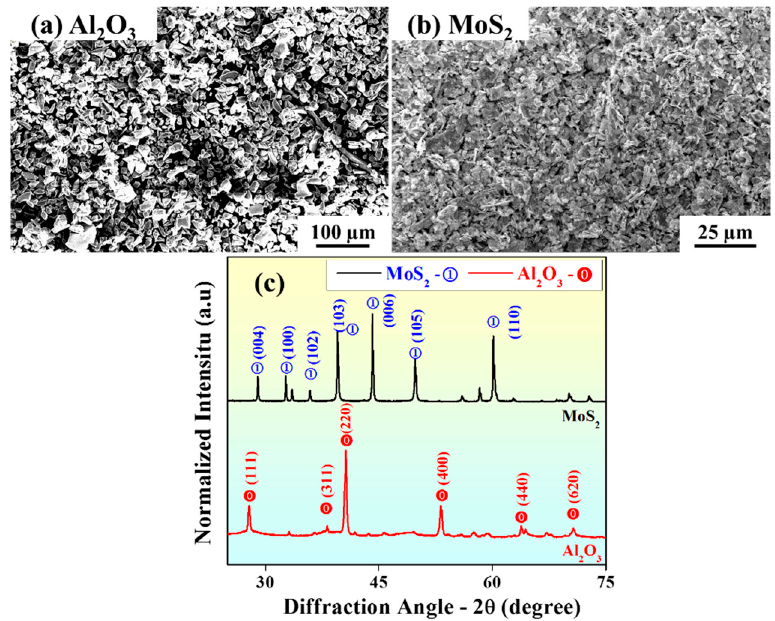
Figure 2. Scanning electron microscopy images showing the powder particle size distributions of ( a ) Al 2 O 3 and ( b ) MoS 2 , and ( c ) their corresponding X-ray diffraction patterns.